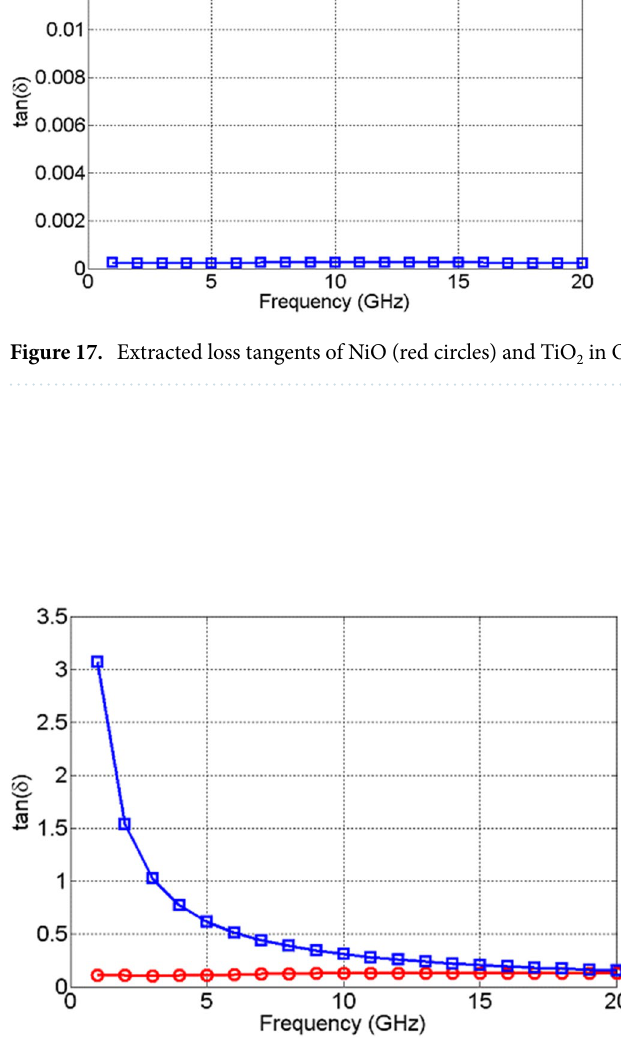
Figure 18. Extracted loss tangents of NiO (red circles) and TiO 2 in ON state (blue